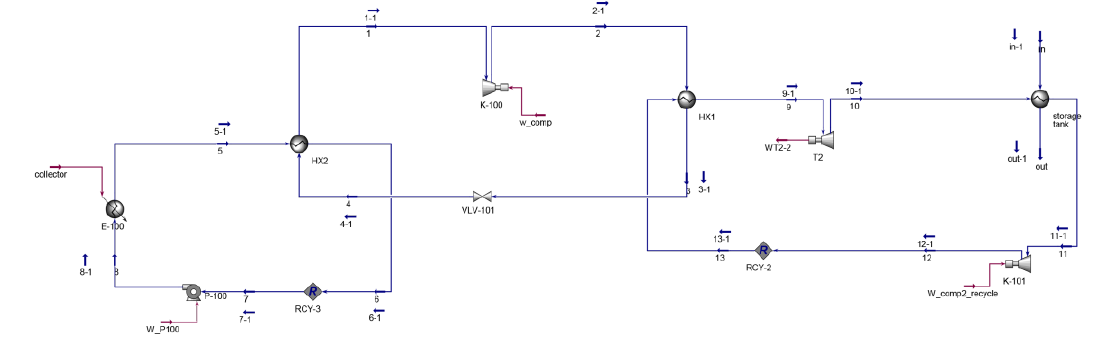
Figure 9. Process status of the modeled system.